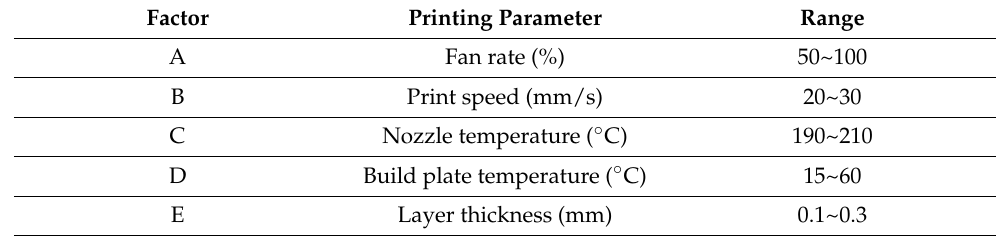
Table 1. Printing parameters and ranges.